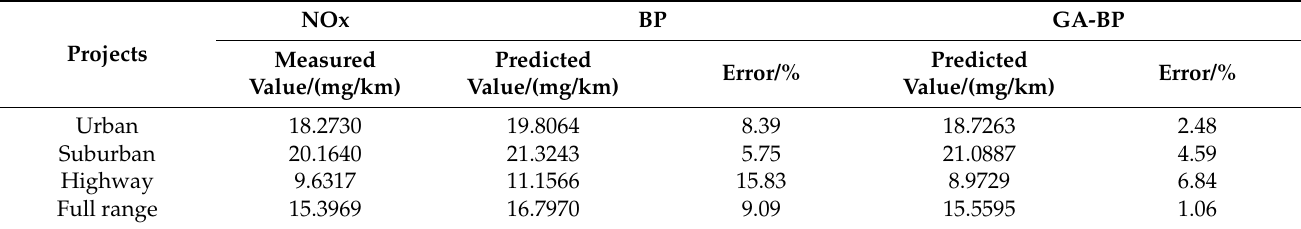
Table 6. Comparison of NOx prediction results under BP and GA-BP NN.